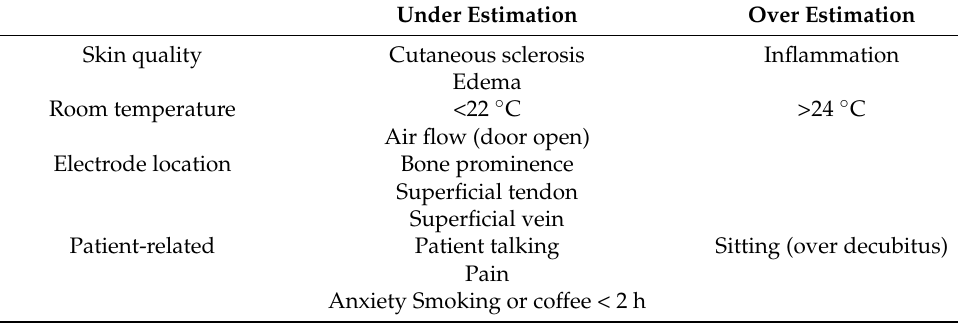
Table 1. Conditions affecting transcutaneous oximetry (TcPO2)